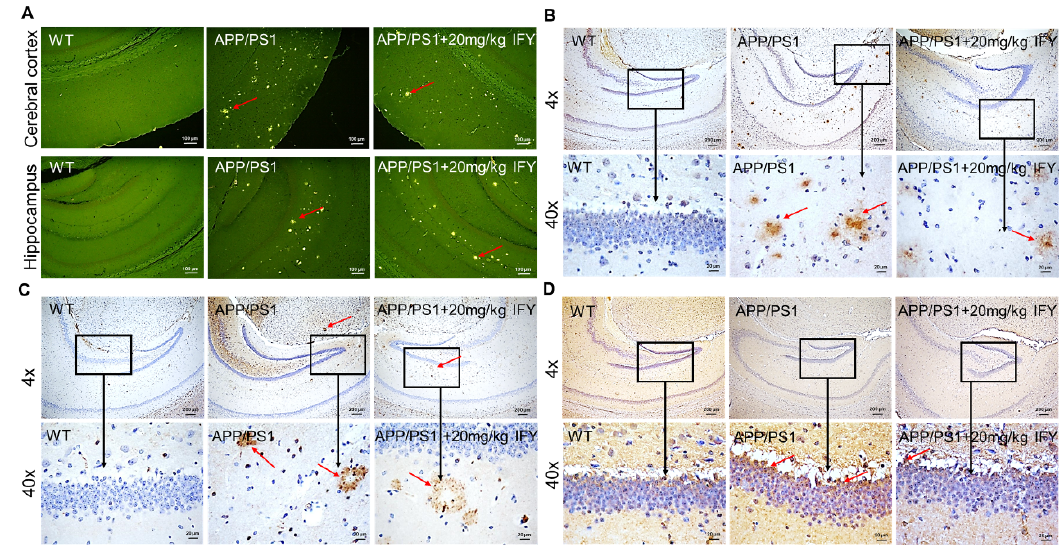
Figure 3. IFY improves Alzheimer's disease (AD)-like symptoms in the brain of APP/PS1 mice. Eight-month-old APP/PS1 mice were treated with IFY (20 mg/kg, i.g.) or treated with saline (0.9%, i.g.) for 42 days. ( A ) IFY prevented the accumulation of A β in the cerebral cortex and hippocampus, observed via thioflavin S staining (magnification × 10, scale bar: 100 μ m ( n = 3)). ( B ) IFY reduced the expression of A β in the hippocampus, detected by immunohistochemical staining. ( C ) IFY suppressed the expression of p-tau in the hippocampus. ( D ) IFY decreased the expression of 4-HNE in the hippocampus studied by immunohistochemical staining. For ( B ), ( C ) and ( D ): magnification × 4, scale bar: 200 μ m, magnification × 40, scale bar: 20 μ m ( n = 3).